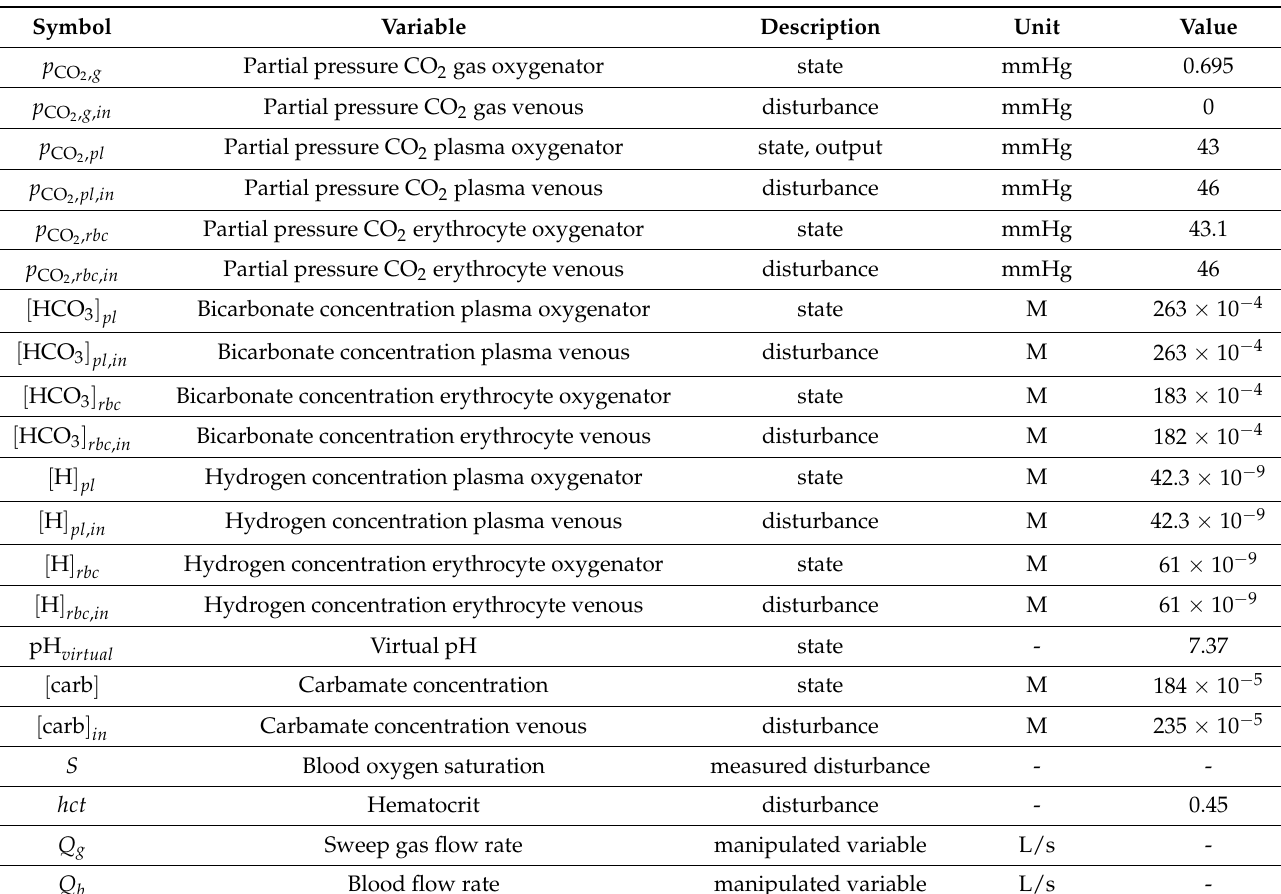
Table A3. Summary of model variables. The initial values for states, actions, and values for model disturbances are shown.